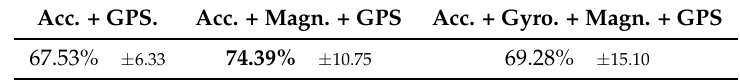
Table 10. Mean accuracies achieved for each set of data, with the best group result highlighted in bold. Acc. +